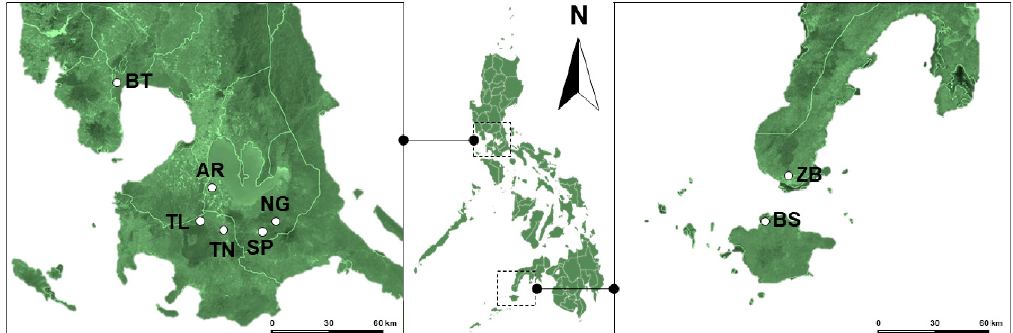
Figure 1. Map of the seven localities with reported A. rigidus outbreaks in the Philippines from 2014 to 2017. The insect rearing facility of the Biological Control Research Unit of De La Salle University labeled “AR”. Dots indicate sampling locations. Northern localities: Orani, Bataan (BT), Nagcarlan (NG) and San Pablo (SP), Laguna, Tanauan (TN) and Talisay (TL), Batangas; Southern localities: Basilan (BS) and Zamboanga (ZB). See Table 1 for the more detailed information regarding location and sample collection information.